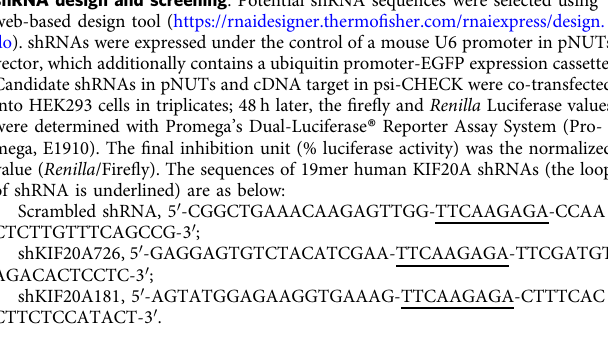
Fig. 4 Inducible knockout of Kif20a in tumor-initiating GNPs causes early cell cycle exit. a After tamoxifen treatment at P4, animal pups were labeled with EdU at P5 and then brains were collected at P6. Co-staining of EdU and Ki67 revealed that knockout of Kif20a in MB-initiating GNPs ( Ptc single- knockout GNPs) resulted in more EdU + Ki67 − cells in the EdU + cell population. White arrowheads indicate the EdU + Ki67 − cells, many of which line outside the proliferating cell zone. Scale bar represents 50 μ m. Quanti fi cations from Fig. 2a (green and red columns) were plotted together in the graph. Data are mean ± SD. P = 1.82E − 05 (between the fi rst two columns) (Student ’ s t -test). b More EdU + Ki67 − cells in the Ptc/Kif20a double-knockout cerebellums were positive for neuronal marker NeuN (white arrowheads). Scale bar represents 50 μ m. Data are mean ± SD. P = 0.00013 (Student ’ s t -test). c After tamoxifen treatment at P4, animal pups were labeled with EdU at P5 and then brains were collected at P7. Co-staining of EdU and Ki67 showed that knockout of Kif20a in MB-initiating GNPs resulted in fewer EdU + Ki67 + proliferating cells in the EGL. EdU + Ki67 + cells within individual cerebellar sulcus were used for quanti fi cation. Scale bar represents 50 μ m. Data are mean ± SD. P = 0.00042 (Student ’ s t